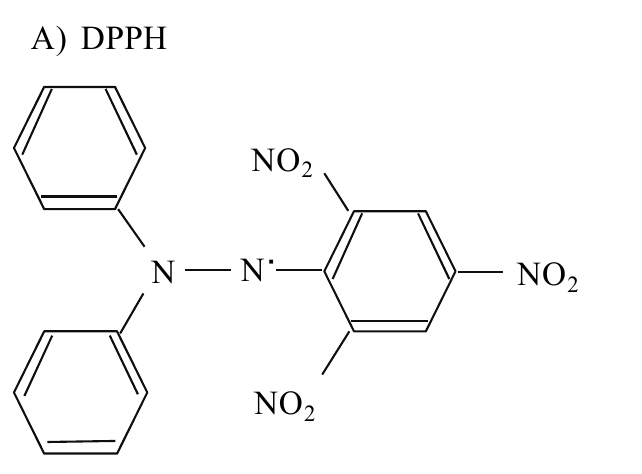
Figure 1. The chemical structures of DPPH and